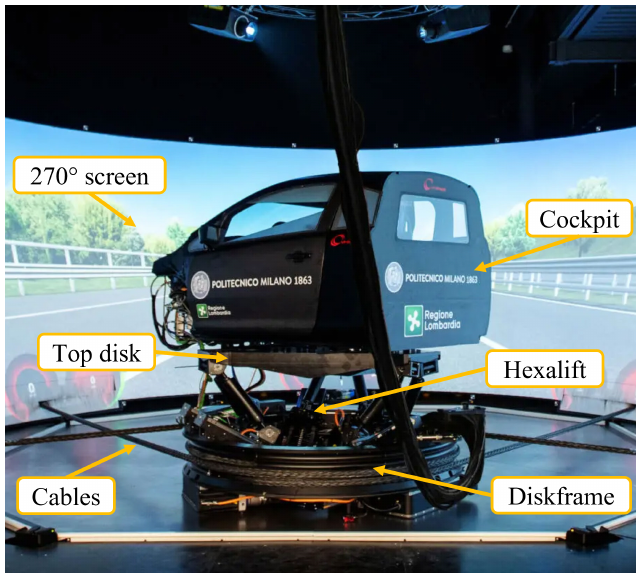
Figure 10. Driving simulator at Politecnico di Milano